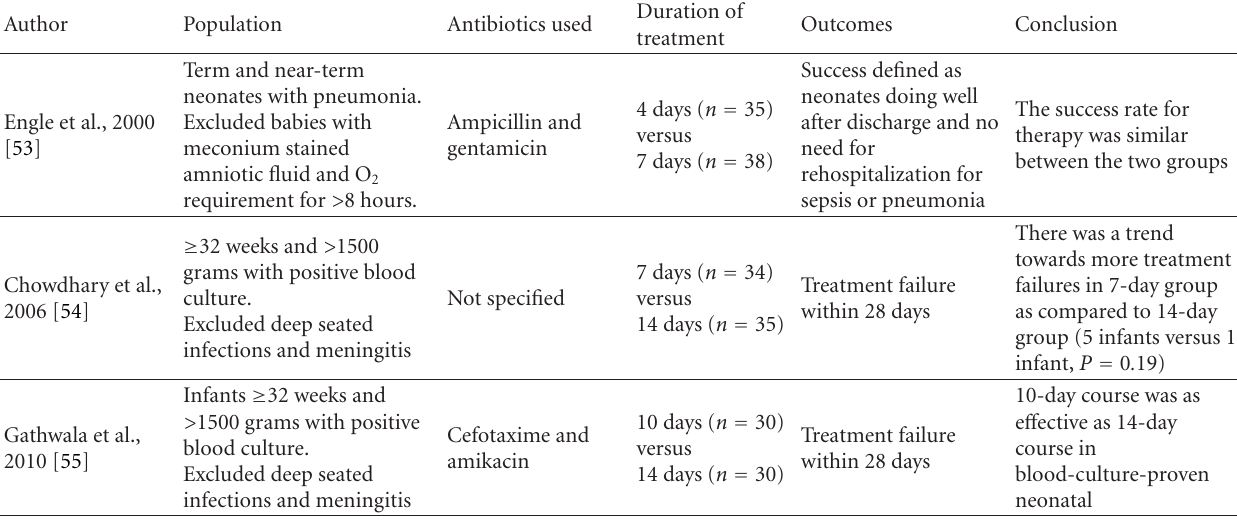
Table 2: Randomized controlled trials of short- versus long-course antibiotic therapy in neonatal bacterial